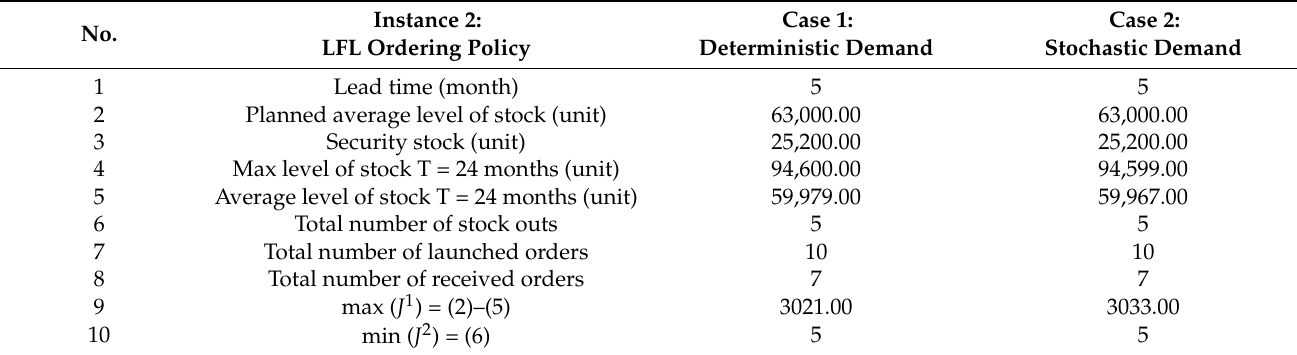
Table 3. Numerical results of Case 1 and Case 2 for Instance 2.